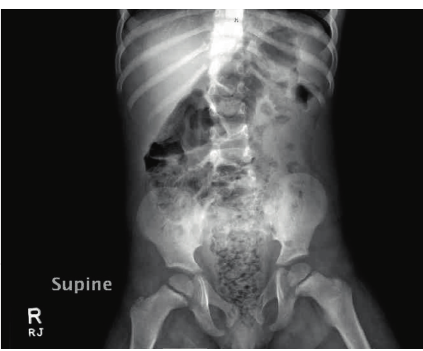
Figure 1: Abdominal X-ray, supine view. There is a nonobstructive gas pattern with moderate stool burden, primarily in the rec- tosigmoid colon and to a lesser extent in the ascending colon.